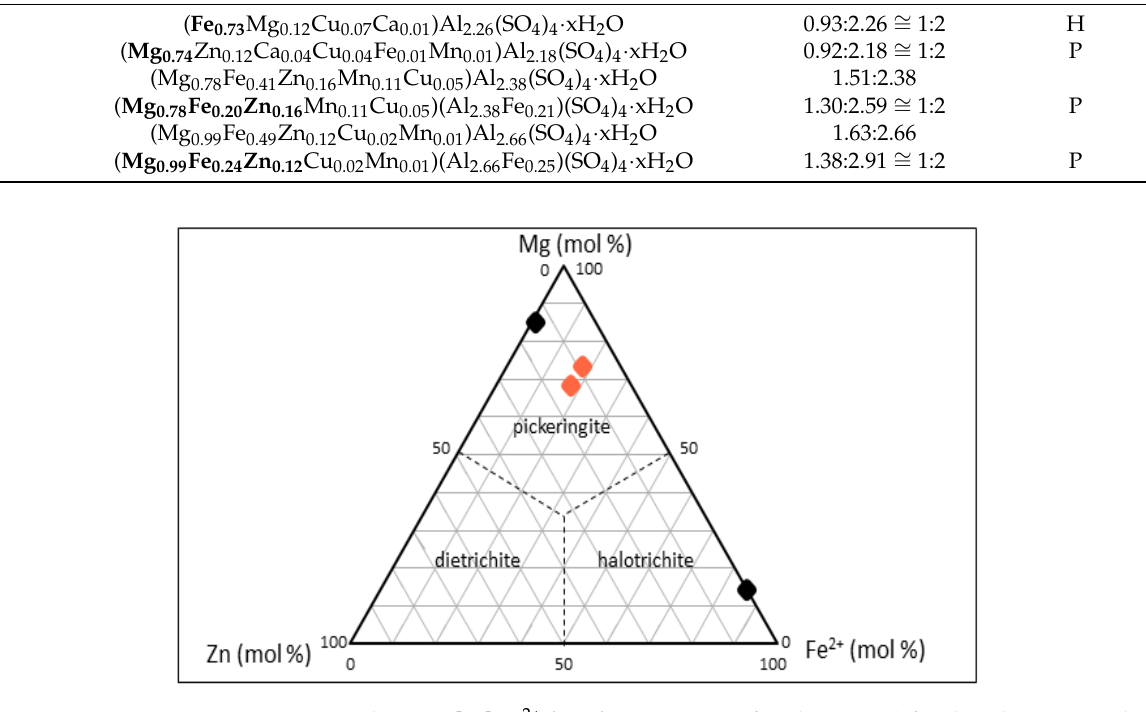
Figure 10. Ternary diagram [36] Fe 2+ /Mg/Zn (in terms of mole percent) for the Algares samples from the halotrichite group (based on SEM-EDS data); orange diamonds—orange samples; black diamonds—white samples.